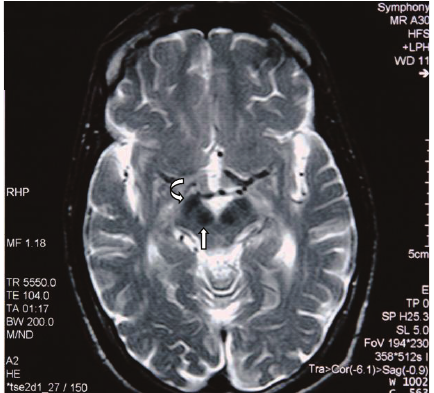
Figure 3: Axial T2 weighted MR image of the brain at the level of the midbrain reveals hypointensity of the red nuclei (straight arrow) and substantia nigra (curved